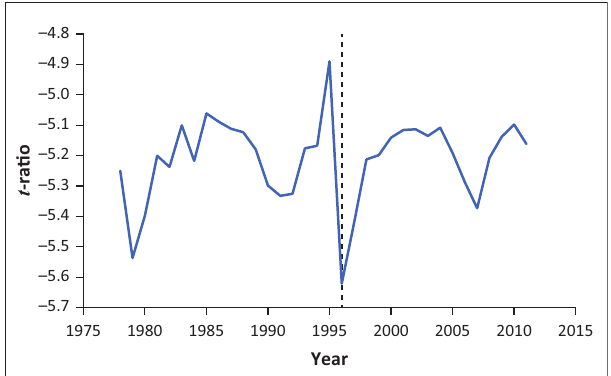
FIGURE 1: Zivot – Andrew breakpoint